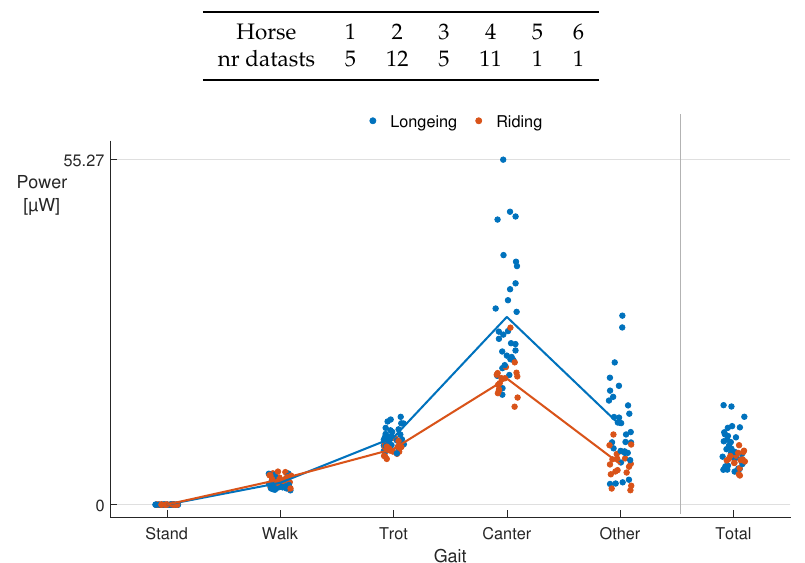
Figure 11. The average generated power in both legs is similar for stand, walk and trot. In canter, the right front leg generates a higher average power. Table 5. The majority of the datasets is collected for horses 2 and 4. Only 1 dataset is measured for the Friesian horse (5) and pony (6).